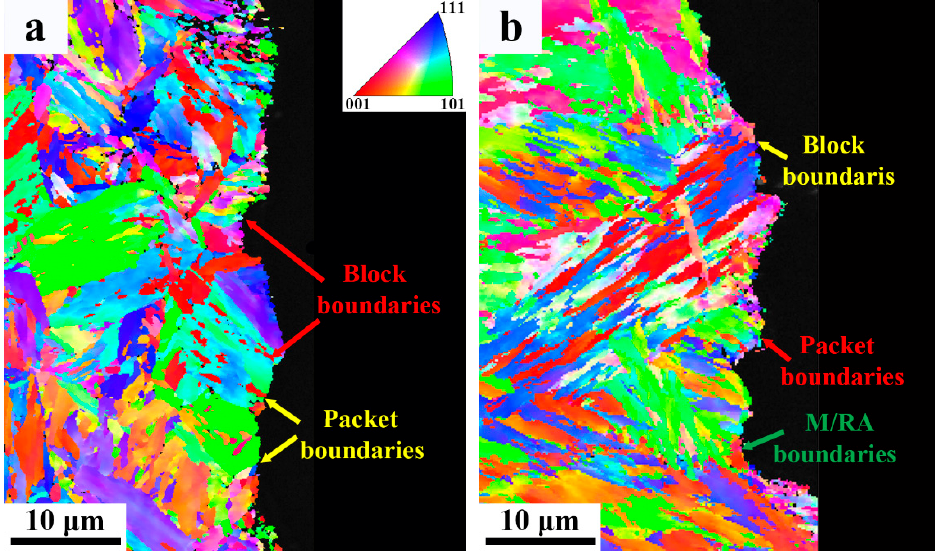
Figure 15. EBSD IPF maps showing the fracture path; ( a ) Base metal; and ( b ) weld metal .